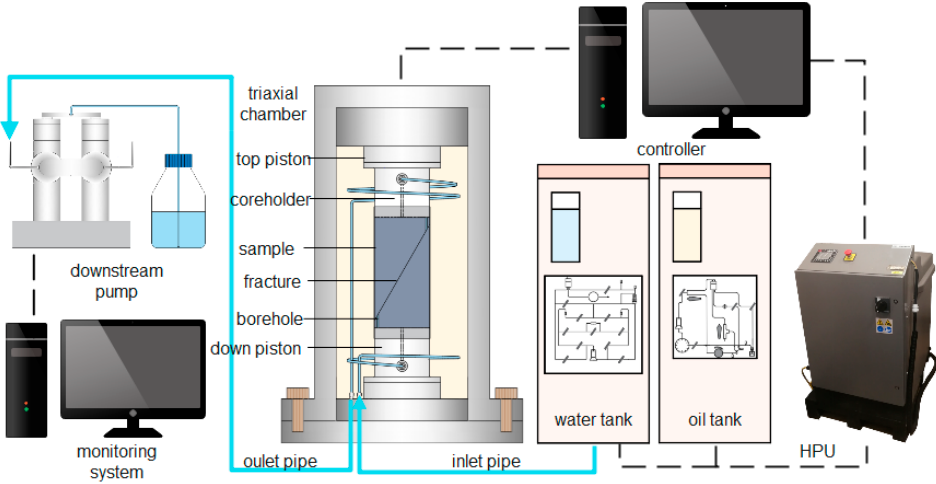
Figure 2. A schematic of the HM-coupling shearing